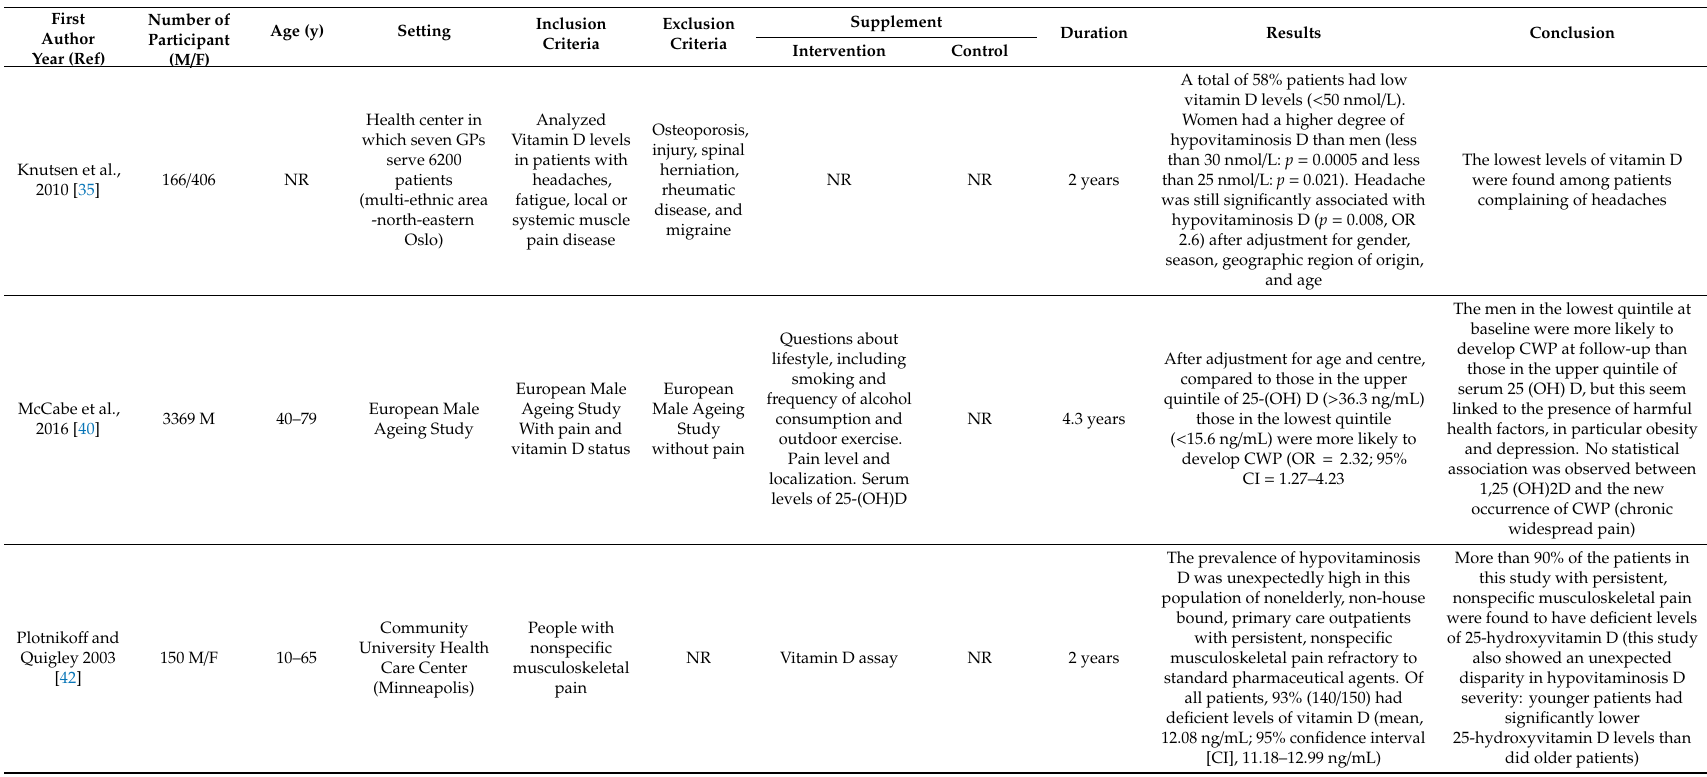
Table 1. Non-Pharmacological Treatments: Vitamin